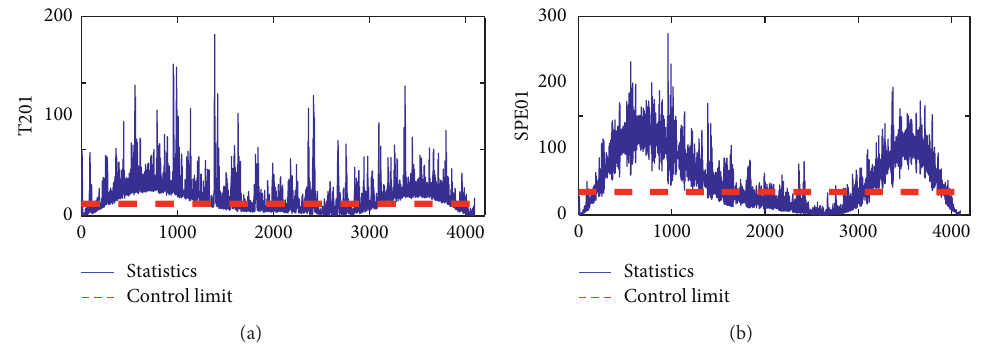
Figure 14: Mechanical failure comprehensive simulation experiment bearing inner ring failure results based on EMD-PCA.